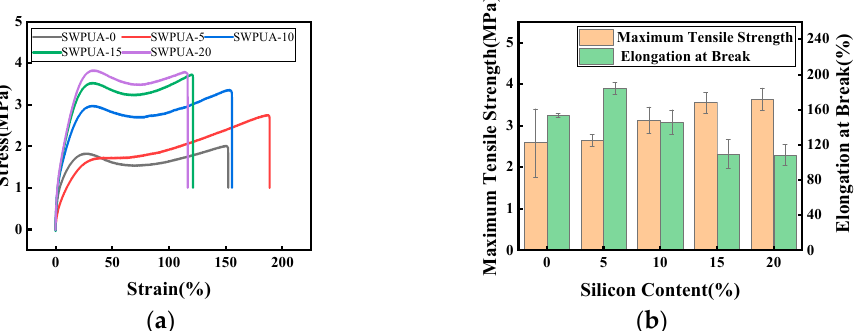
Figure 6. ( a ) Stress–Strain curves of SWPUA samples with di ff erent silicon content; ( b ) Maximum tensile strength and Elongation at break of SWPUA samples with di ff erent silicon content. Table 2. The maximum tensile strength and elongation at break of SWPUA coatings with di ff erent silicon content.